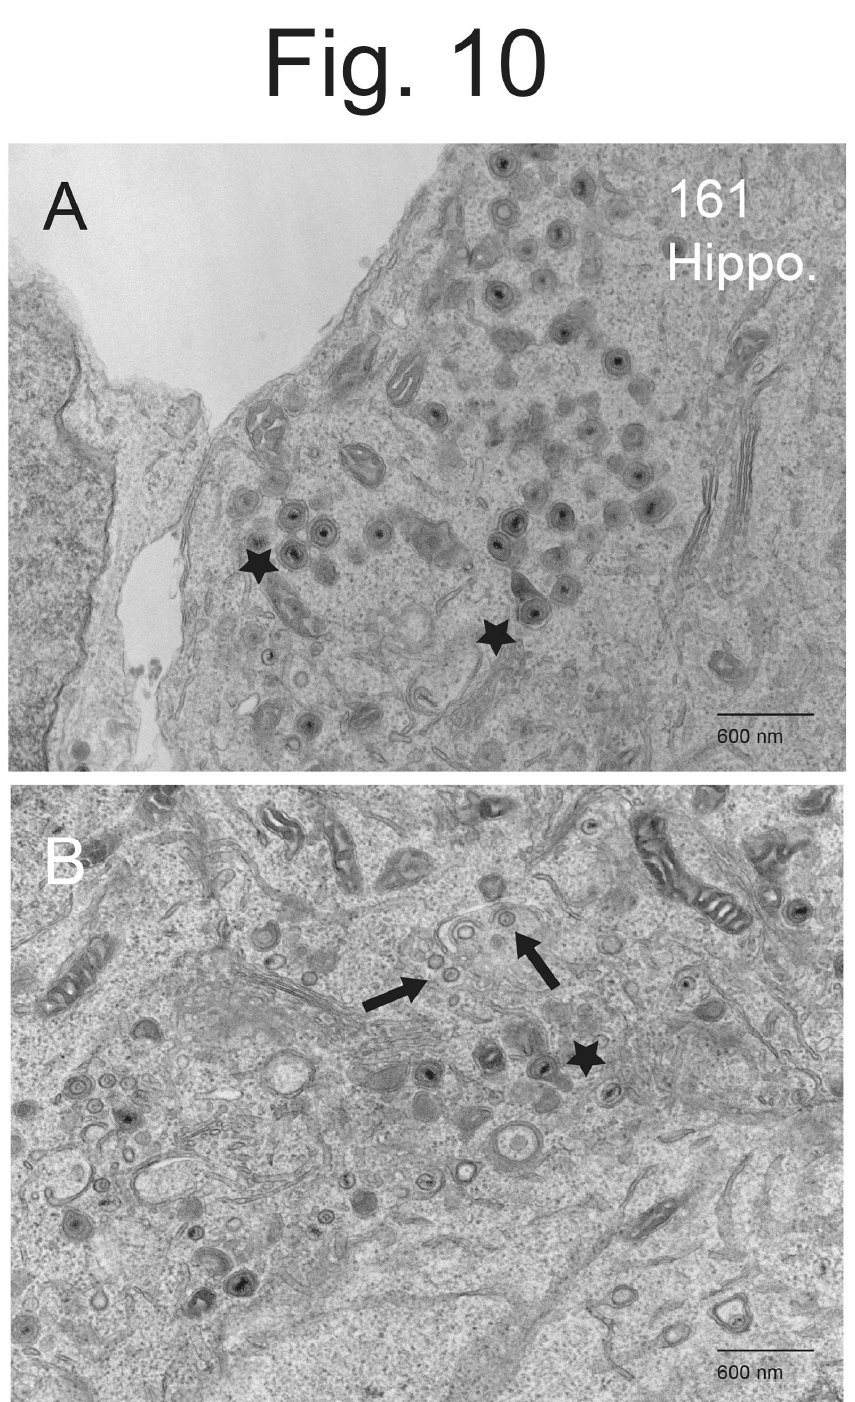
Figure 10. Higher Magnification EM of Hippocampal Neurons Infected with PRV 161. Hippocam- pal neurons on Thermanox slides were infected with PRV 161 then processed for EM. Panel ( A ) shows enveloped virus particles in the cytoplasm and no particles on cell surfaces. There were clear exam- ples of vesicles that contained more than a single virus particle and a cytosolic enveloped virus with an oblong appendage of electron-dense material extending from one pole of an enveloped virion (stars). Panel ( B ) represents a higher magnification of panel Figure 9B showing numerous cytoplasmic enveloped capsids, some that were bound to membranes and partially enveloped (solid arrows). There was also an example of an enveloped virus particle with an oblong protrusion of electron-dense material (star) and numerous unenveloped